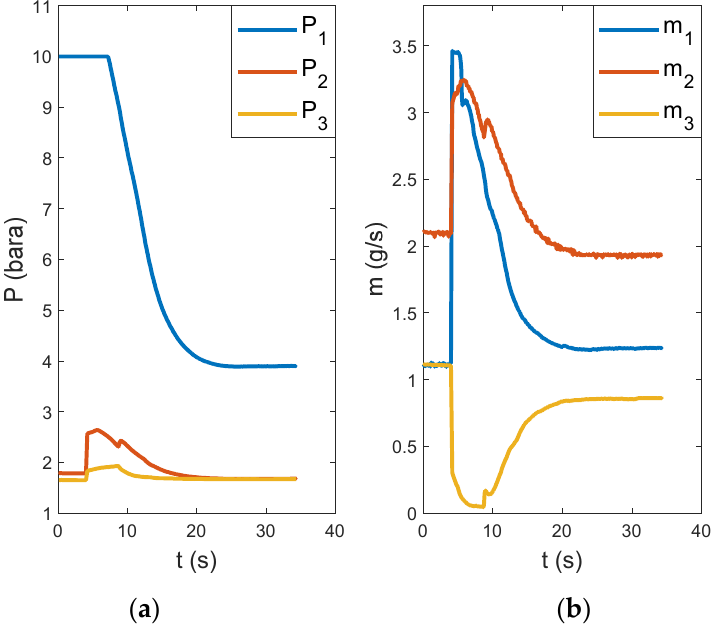
Figure 10. Pressure and mass flow rate fluctuation when switching from Ejector A to B: ( a ) pressure variation; ( b ) air mass flow ‐ rate variation.